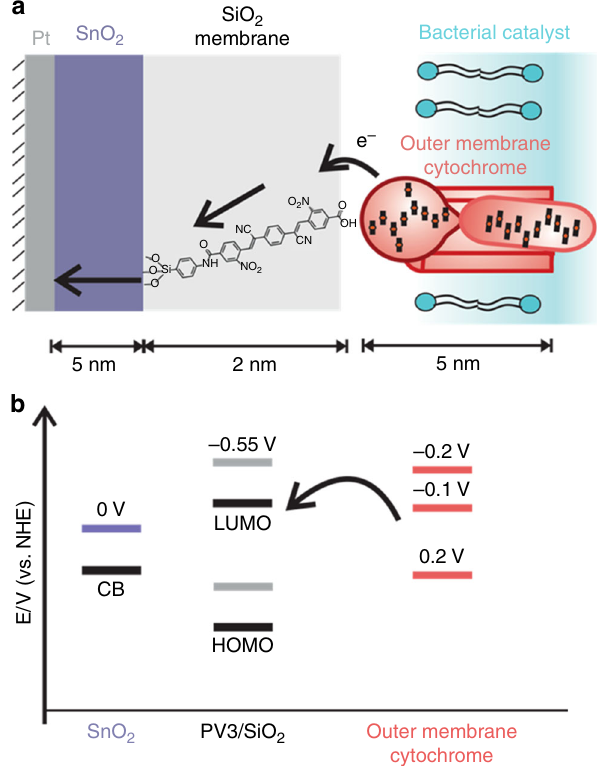
Fig. 1 Electron transfer path and energy diagram at the designed biotic/ abiotic interface. a Electrons are transferred from S. oneidensis outer membrane cytochrome c to the LUMO of the molecular wire embedded in a 2-nm-thick SiO 2 membrane and then to the inorganic catalyst layer (SnO 2 ). b Energy levels of outer membrane cytochromes c (red), the PV3 molecular wires (gray), and the SnO 2 layer (purple) based on measured values of each component in isolation. When assembled and positively biased in the complete construct, the energy levels of the PV3 wires and SnO 2 layer are likely shifted (indicated in black) to more positive